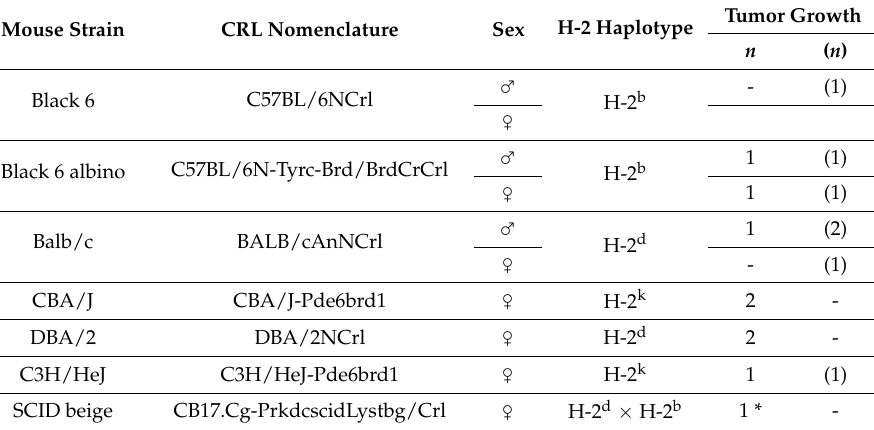
Table 2. Mouse strains and sex included in generation of